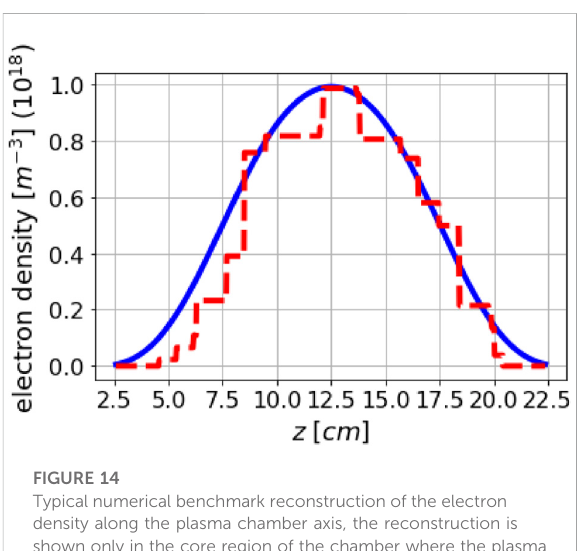
FIGURE 14 Typical numerical benchmark reconstruction of the electron density along the plasma chamber axis, the reconstruction is shown only in the core region of the chamber where the plasma density assumes largest